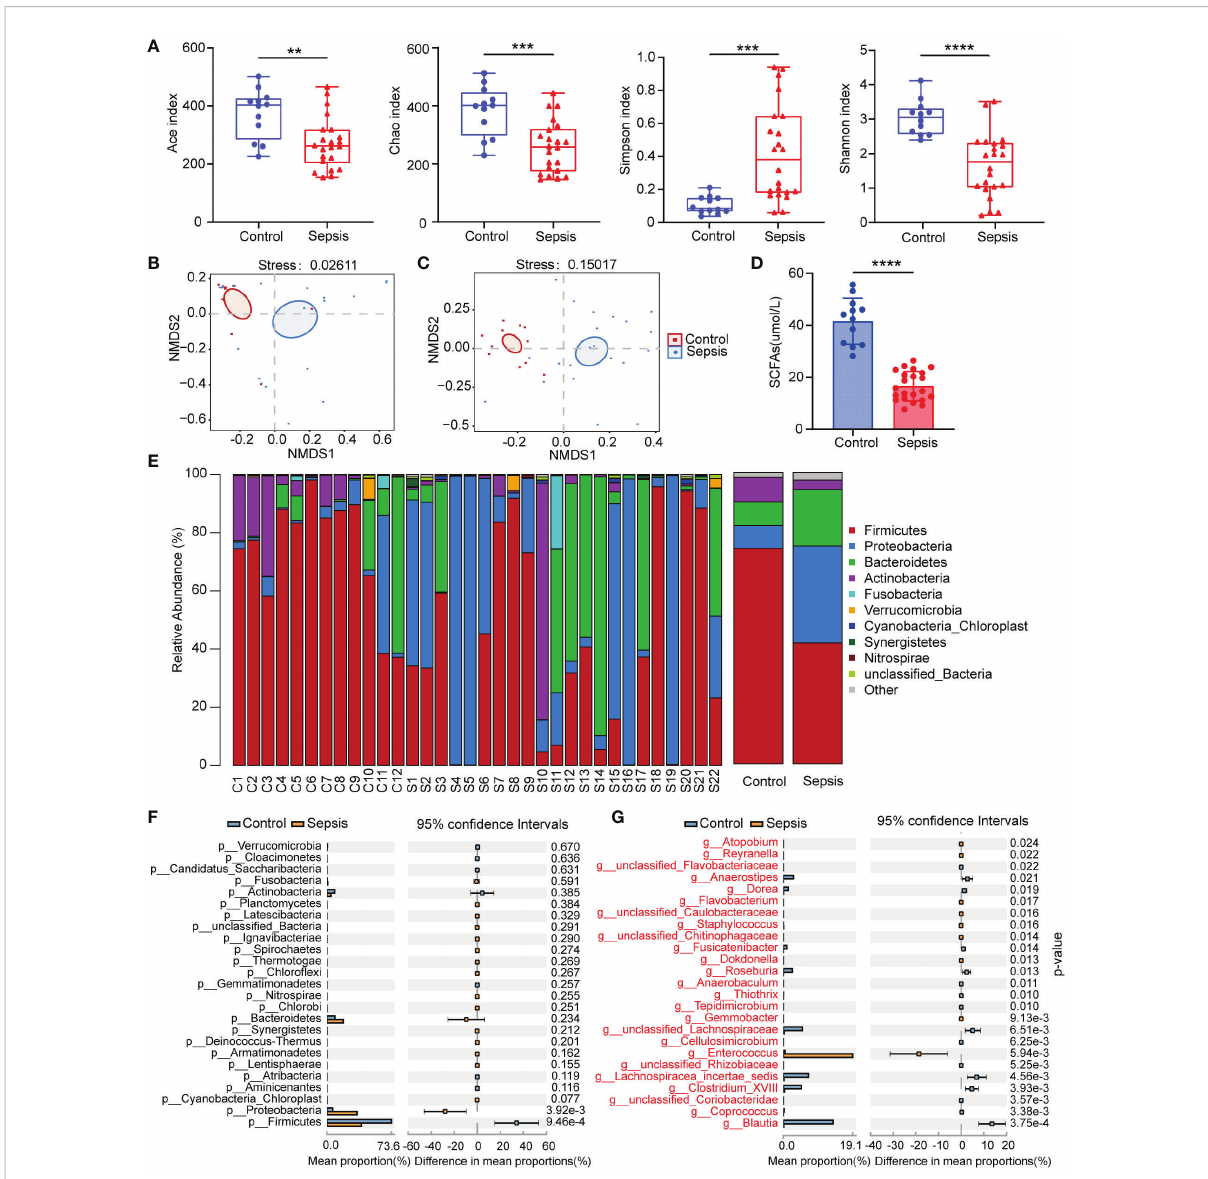
FIGURE 1 Human sepsis-related alterations in the gut microbiota. (A) The Ace, Chao, Shannon, and Simpson indices were used to compare the alpha diversity pro fi les of healthy individuals (n = 12) and patients with sepsis (n = 22). (B, C) NMDS analysis of beta diversity at the phylum and genus levels. Different hues symbolize different groups. The species in the two samples are more similar the closer the two sample points are to each other. (D) Comparison of serum SCFAs levels among two groups. (E) The distribution of the community at the phylum level. Different colors indicate distinct species, and the length of the columns indicates the relative abundance of those species in the group sample (represented by the Y-axis). (F, G) Variation in gut microbiota between the groups was statistically signi fi cant at the phylum and genus levels. **P < 0.01; ***P < 0.001; ****P <